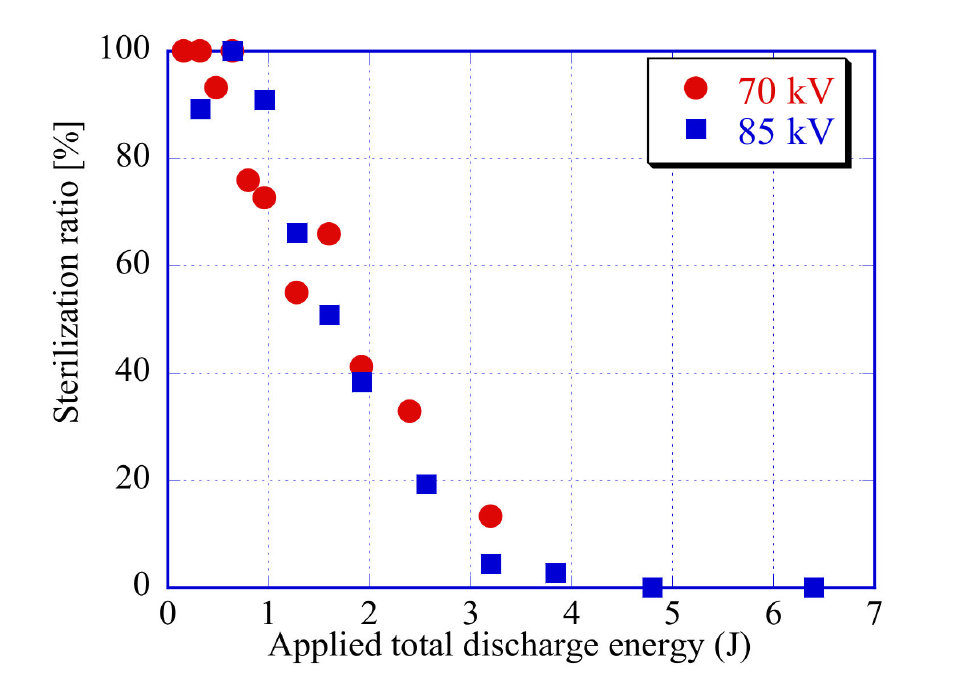
Figure 7. Survival ratios of E. coli on the surface of agar medium in configuration (1) for applied total discharge